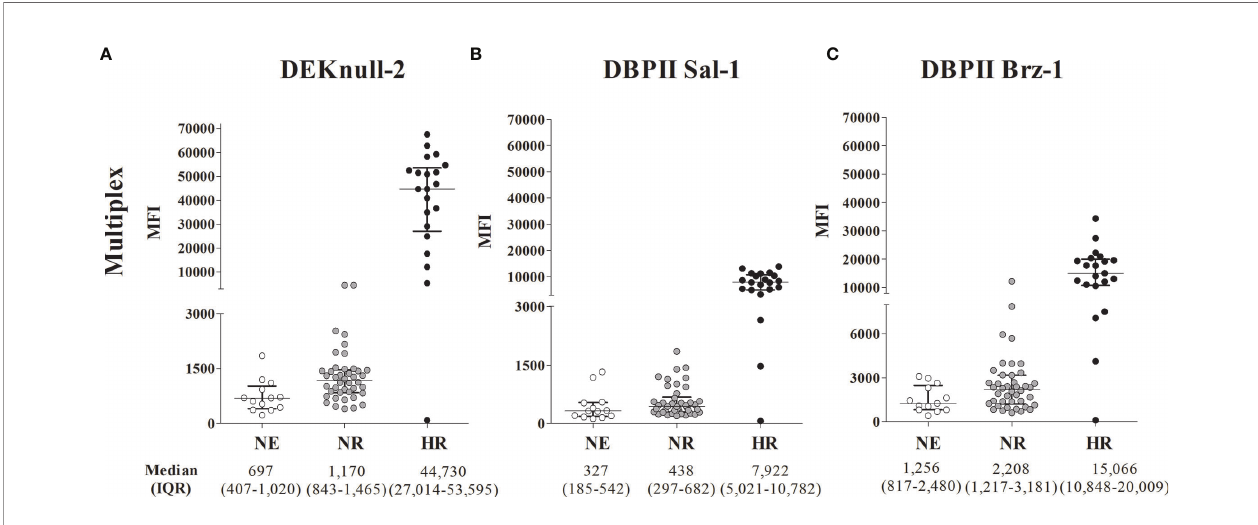
FIGURE 2 | DBPII multiplexed microsphere-based cytometric assay in Plasmodium vivax plasma samples from individuals previously characterized as DBPII high responders (HR), non-responders from the malaria-endemic area (NR) or non-exposed (NE). Scatter plots of mean fl uorescence intensity (MFI) for individual samples (n = 76) from the endemic area performed with the cytometric bead-based assay multiplex to DEKnull-2 (A) , and native DBPII (B, C) . The samples were classi fi ed according to tercile intervals of reactive index (IR) of ELISA response and inhibitory response (BIAbs) evaluated by COS-7 assay as: High reactive (HR, n = 21), IR ≥ upper tercile and high inhibitory response (black circles); non-responders (NR, n = 42), who presented IR < 1 and negative inhibitory response (dark gray circles) and non- exposed (NE, n = 13), represented by individuals from a non-endemic area (white circles). Median and interquartile range (IQR) values are represented for each group.